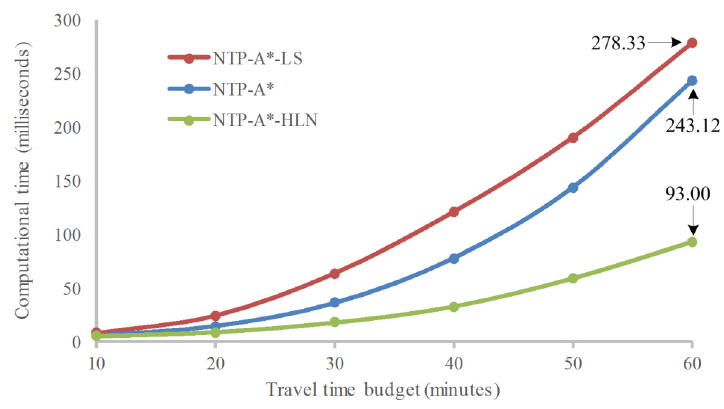
Figure 5. Computational times of three different implementations of the NTP-A* algorithm.